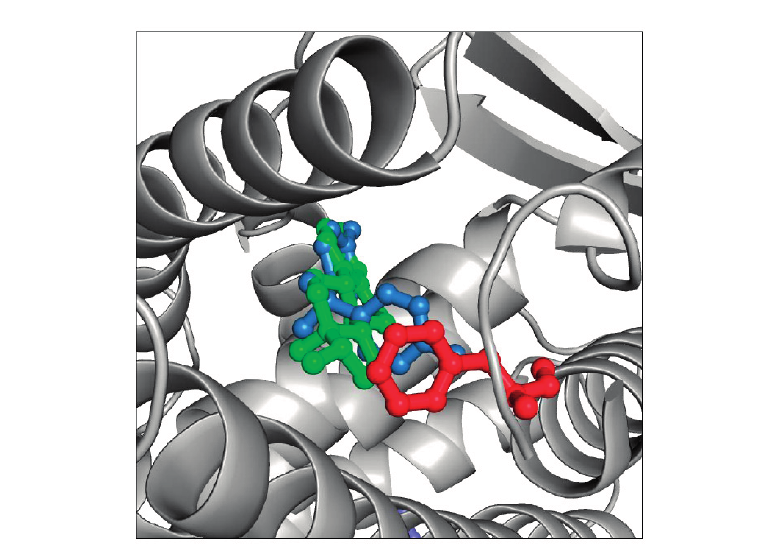
Figure 4. Part of the ER ligand binding domain is shown in grey cartoon, with the M421F mutation (see main text) shown in red. Computational simulations predict this ER mutant to have an increased affinity for estradiol (green) and bisphenol (blue). The two molecules cannot bind simultaneously but are shown superimposed in the ligand binding pocket for